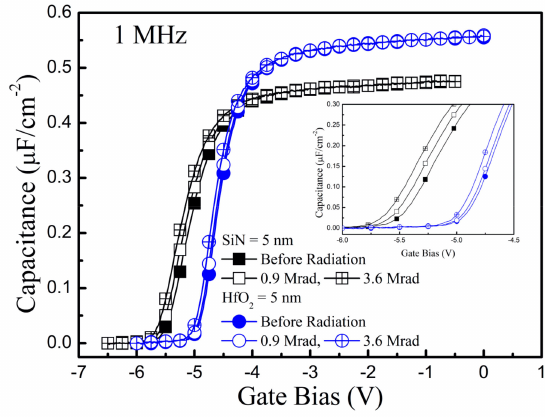
Figure 4. Capacitance-voltage measurements before and after the γ -ray irradiation in GaN-based MIS-HEMTs for a 5 nm-thick SiN and HfO 2 gate dielectric